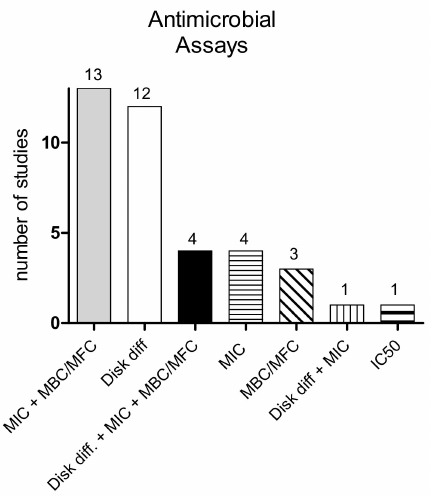
Figure 3. Graphical picture of the distribution of antimicrobial assays in the thirty-eight studies analyzed. A major portion of them ( n = 36, constituting the 65.7%) employed either MIC, or MBC, or their combination also with disk diffusion agar, while 31.6% were based only on a disk diffusion agar test, and 2.6% (one single study) only on IC50